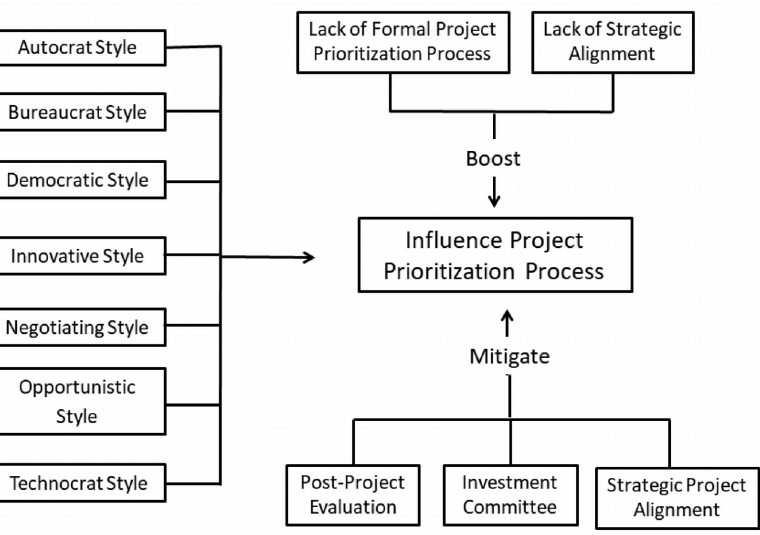
Figure 3. Sponsor’s managerial styles influence on project prioritization